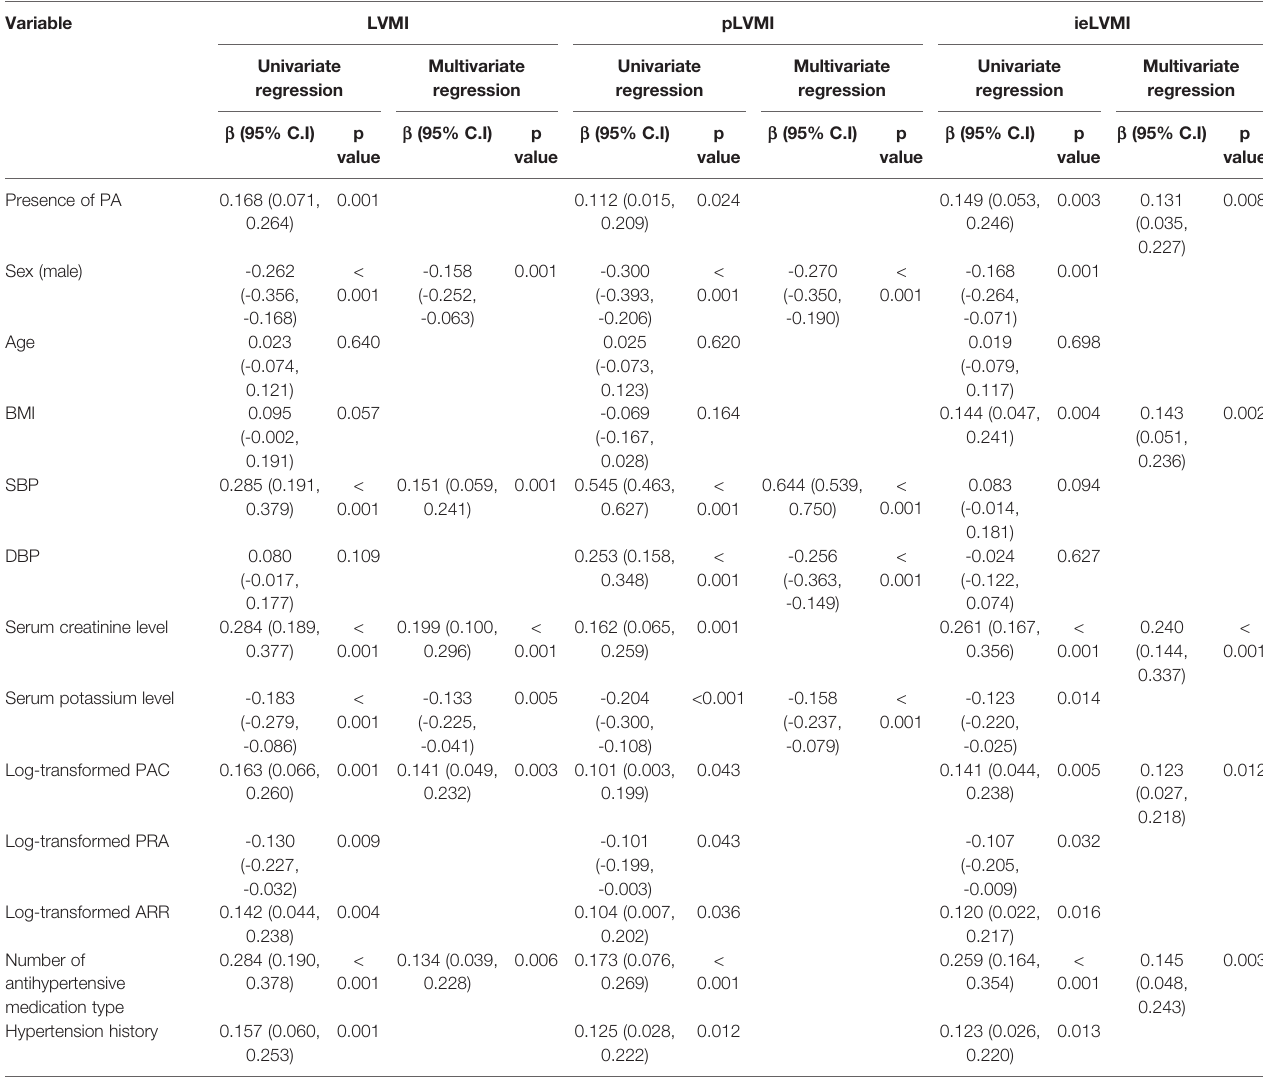
TABLE 3 | Correlation study between LVMI, pLVMI, and ieLVMI and clinical parameters (after propensity-score matching adjusted for age, sex, SBP, DBP, antihypertensive types, hypertension years) (n = 426). Variable